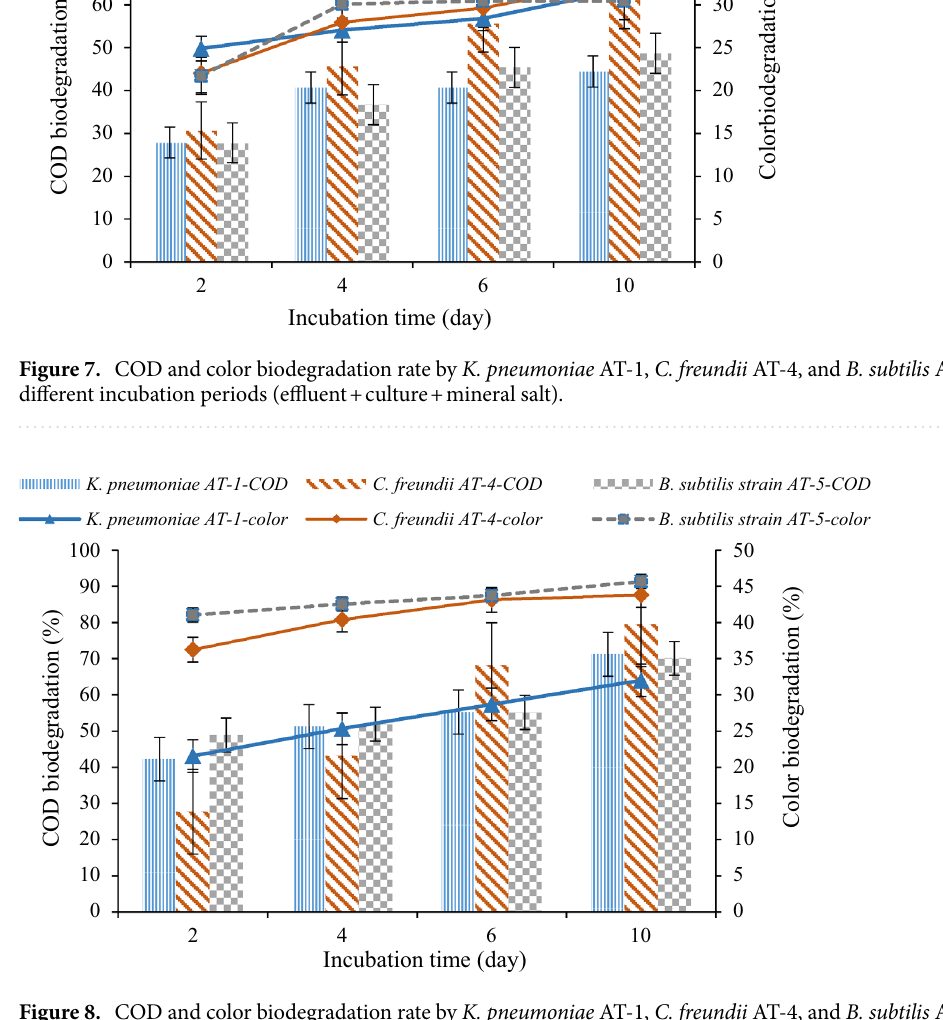
Figure 8. COD and color biodegradation rate by K. pneumoniae AT-1, C. freundii AT-4, and B. subtilis AT-5 in different incubation periods (effluent + culture + mineral salt +